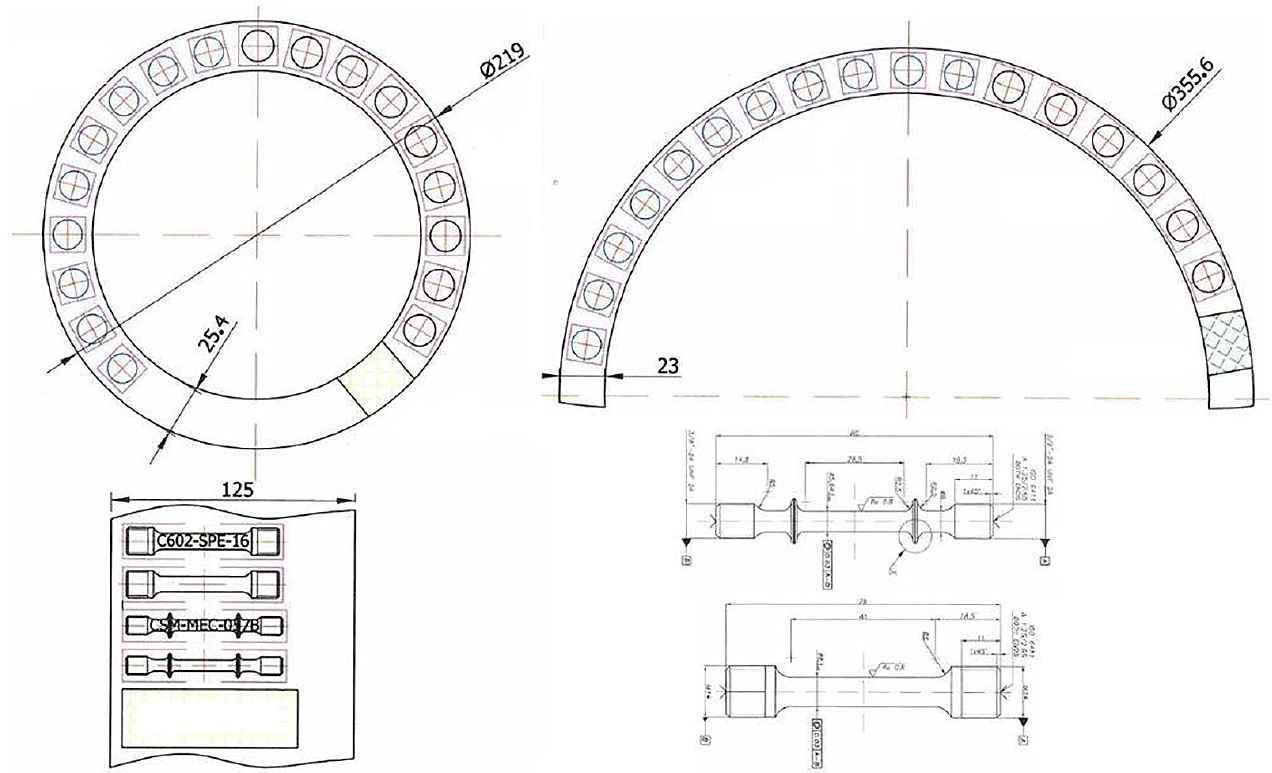
Figure 3. The specimen geometries: P91 tube cutting plan, upper-left side; P92 tube cutting plan, upper-right side; the specimens according to ISO 204:2009, lower-right side.